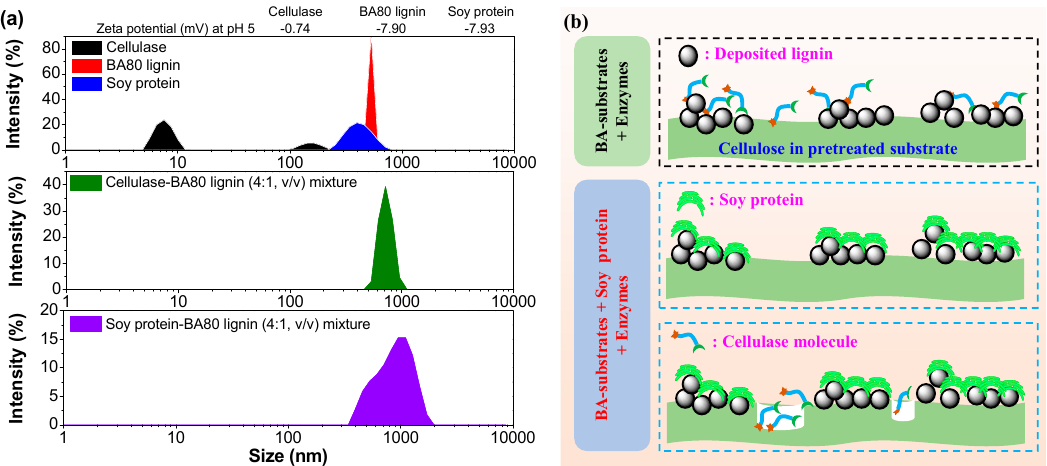
Figure 8. ( a ) Zeta potential and particle size of cellulase, BA80 lignin, soy protein and their mixtures; ( b ) a schematic diagram for promoting the enzymatic conversion of cellulose in BA80 pretreated solid substrate by using soy protein.